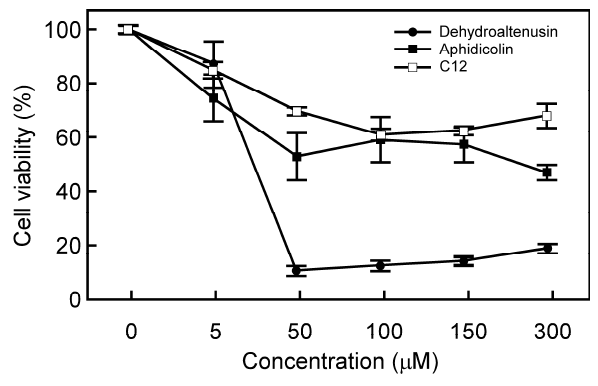
Figure 3. Effect of inhibitors on the cell proliferation of NIH3T3 cells. Dose-dependent inhibition of NIH3T3 cell growth incubated with various concentrations of dehydroaltenusin (closed circle), C12 (open square) or aphidicolin (closed square) for 24 h. Cell proliferation was determined by MTT assay. Cell viability in the absence of the compounds was taken as 100%. Values are shown as the means ± S.E. for five independent